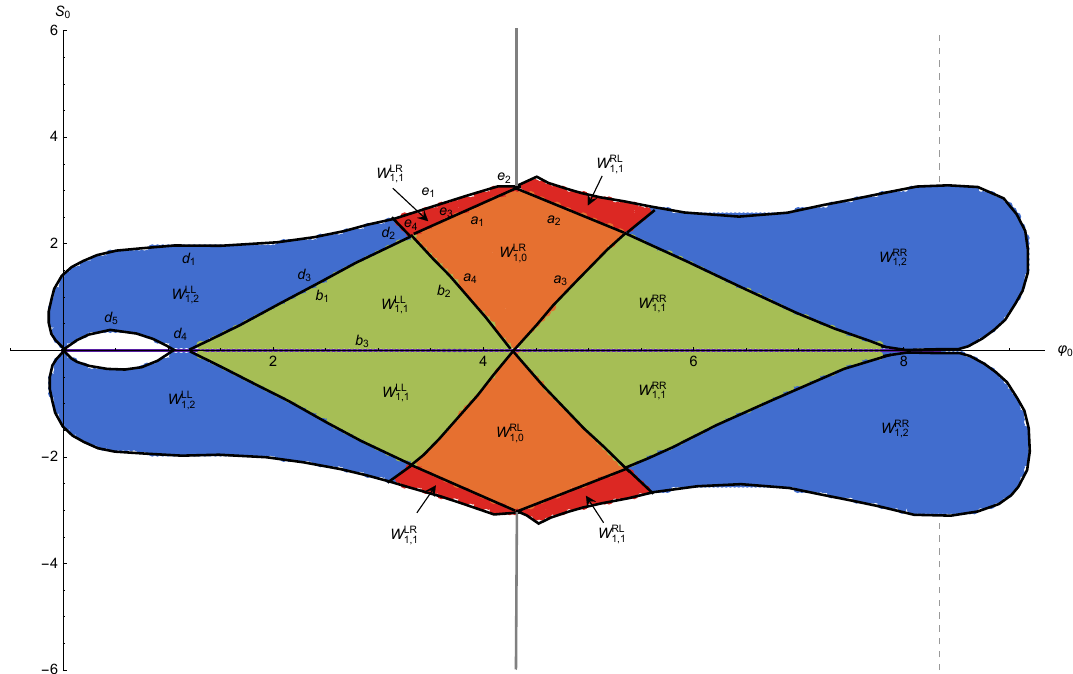
Figure 8 . The connected space of solutions found with one A-bounce. The orange, green, blue and red regions correspond to W LR , W LL , W LL and W LR solutions respectively. The horizontal line of 1 , 0 1 , 1 1 , 2 1 , 1 S 0 = 0 is the space of type S solutions. The diagonal lines (curves) between orange and green or red and blue regions are the space of W L Min + solutions. The vertical dashed lines show the location of 1 , 1 the potential minimum ϕ in the middle and the potential maximum ϕ on the right. The W L Min − 1 2 0 , 0 class of solutions does not explicitly appear in this moduli space but emerge in more intricate ways that will be explained in section